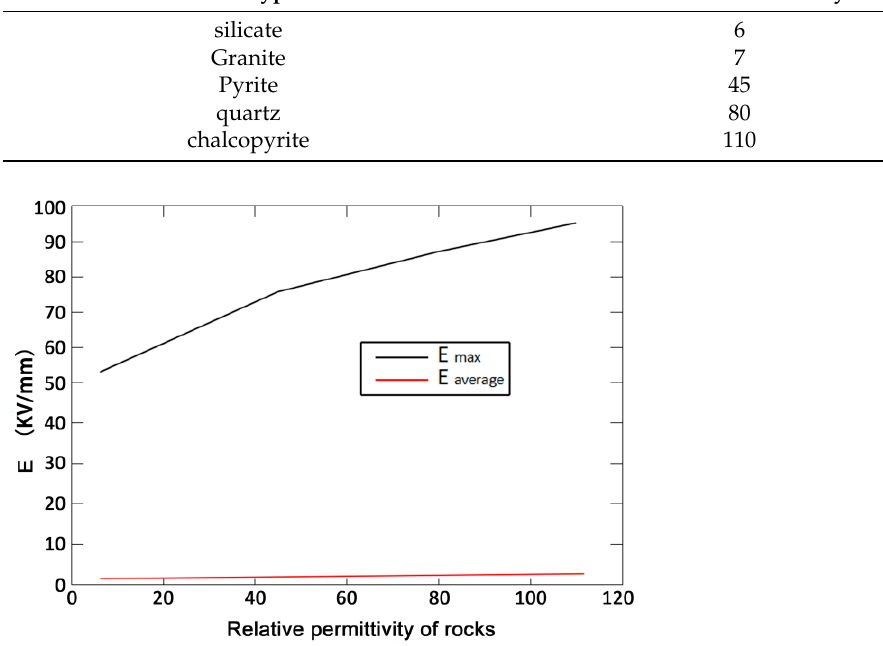
Figure 17. The variation of rock EFS with rock dielectric constant (Under the same electric param- eter influence condition). influence condition).